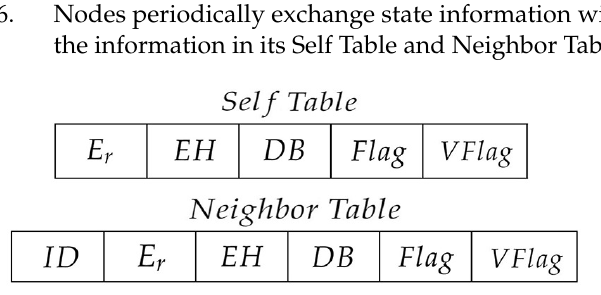
Figure 1. Data conservation structure.